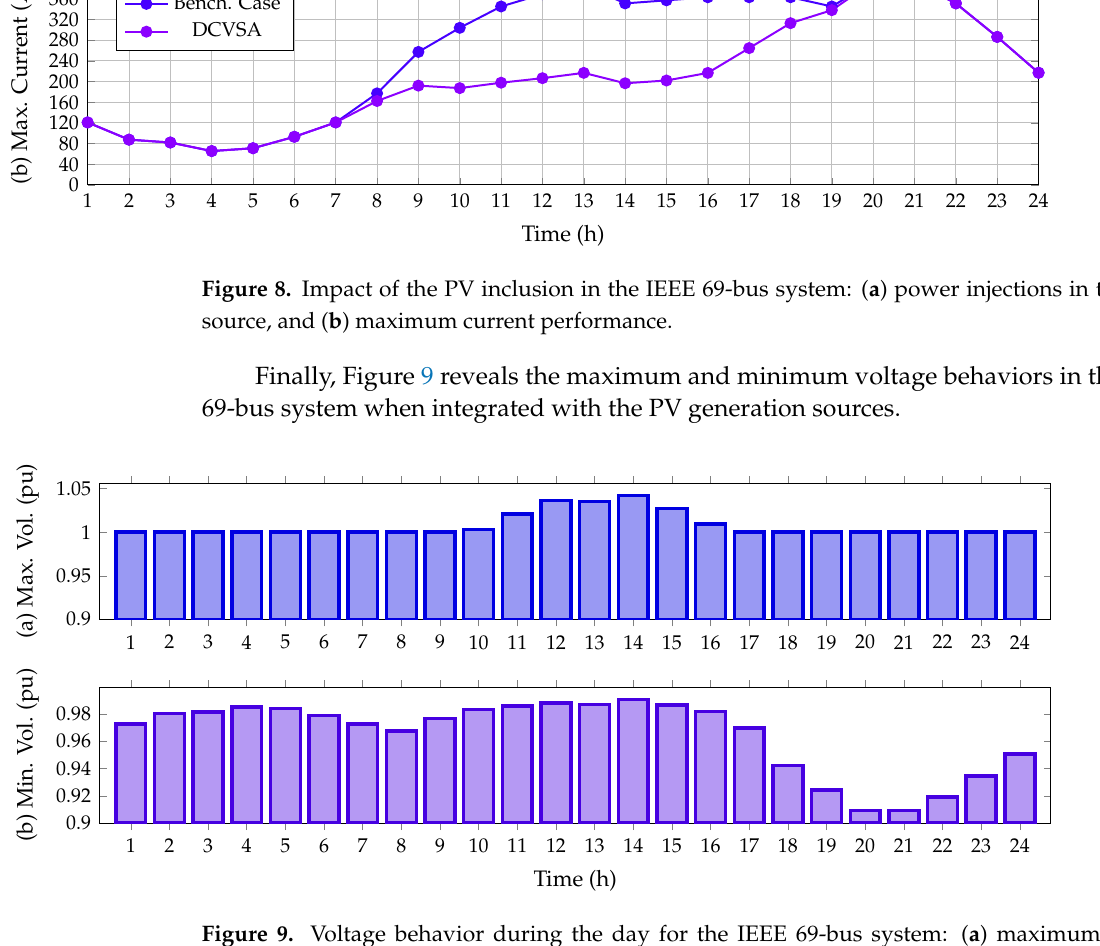
Figure 9. Voltage behavior during the day for the IEEE 69-bus system: ( a ) maximum voltage magnitude and ( b ) minimum voltage